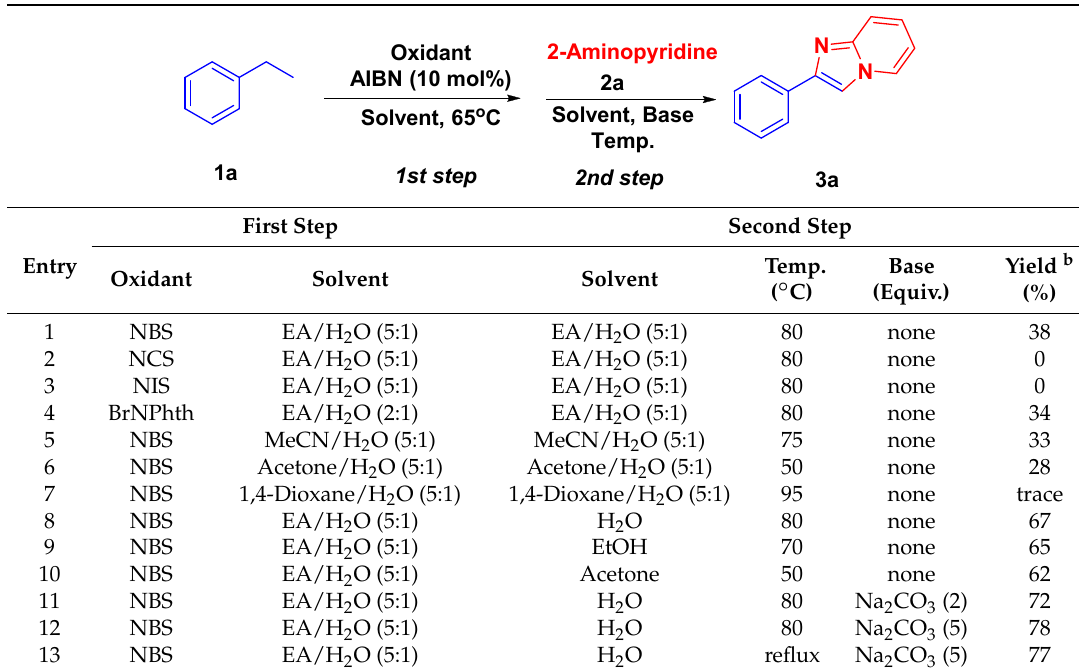
Table 1. Optimization of reaction conditions a .